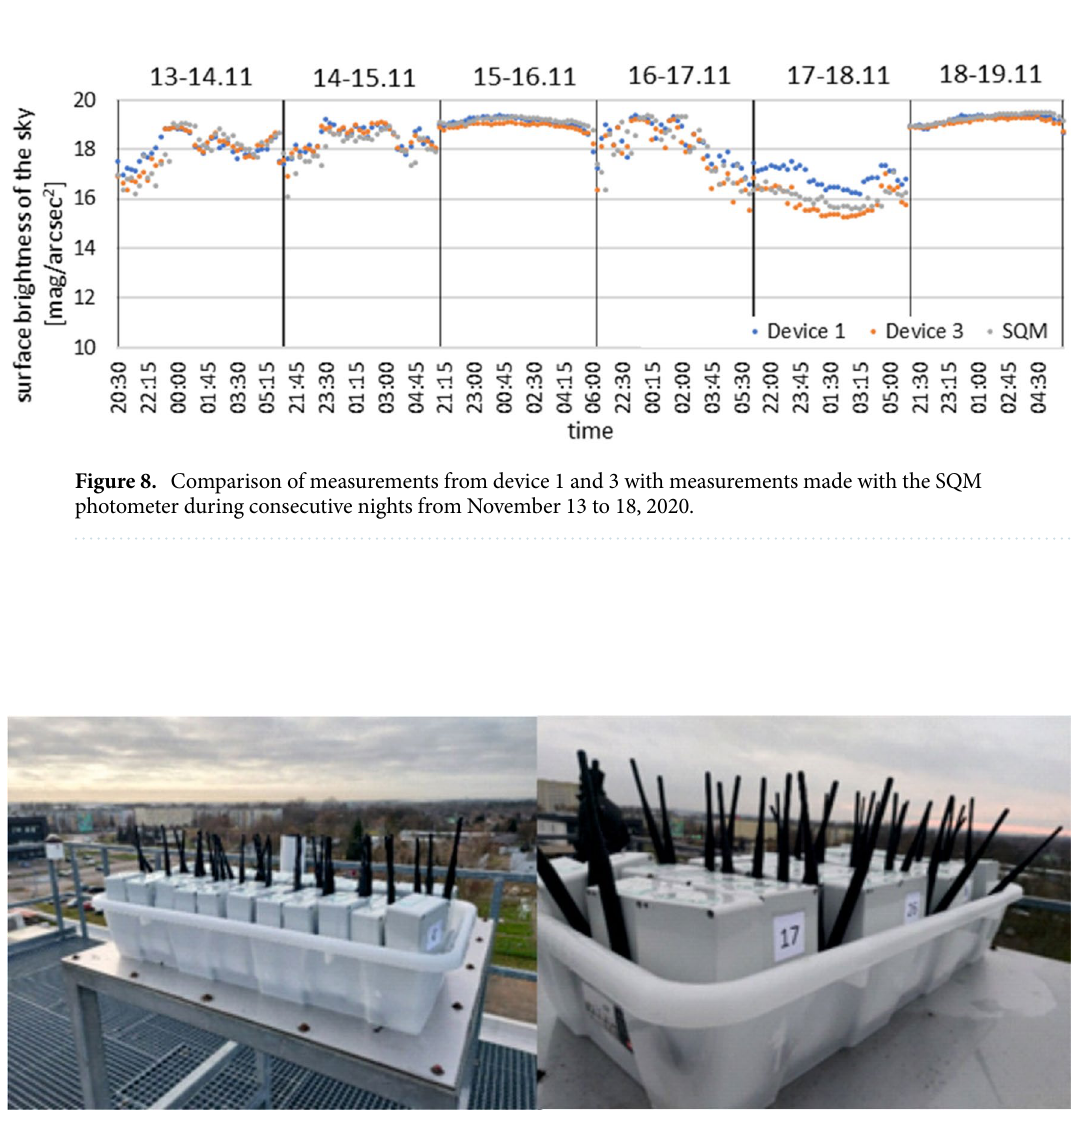
Figure 9. Test the cloud of 35 devices for measuring the sky brightness in winter 2020 on the terrace of the NCU Meteorological Observatory in Toruń (Poland) (photo by Mieczysław